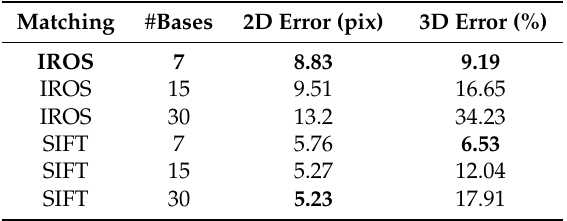
Table 5. Rendered flag sequence: performance vs. the number of bases for IROS- and SIFT-based